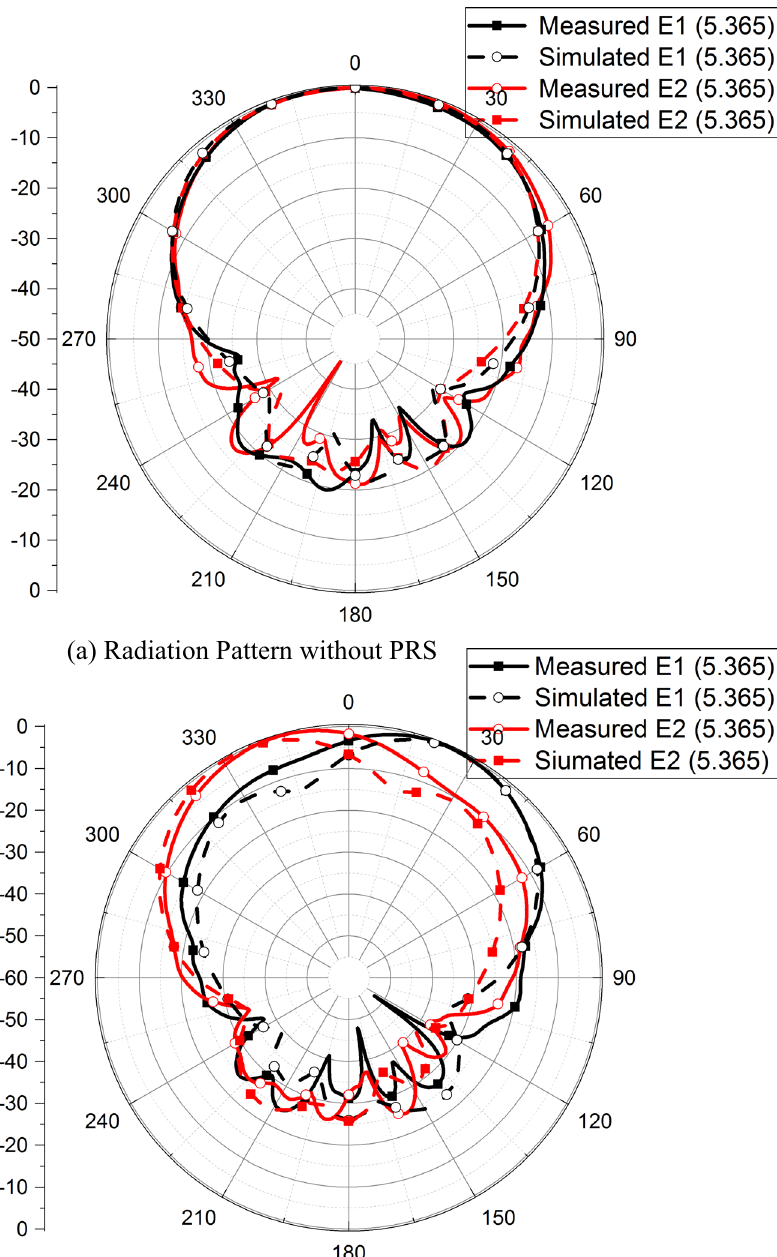
Figure 11. Measured vs Simulated Results.